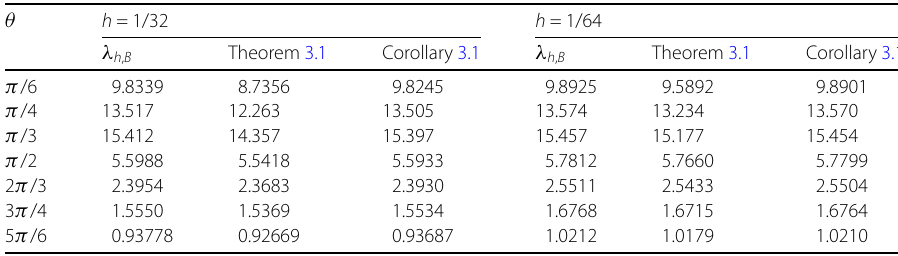
Table 1 The lower bounds for λ through Theorem 3.1 and Corollary 3.1